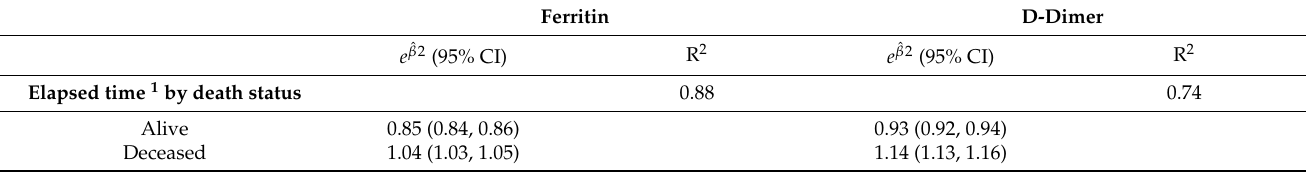
Table 5. Both ferritin and D-dimer levels consistently decreased over time for patients who remained alive, while increasing over time for patients who eventually died. Table 5. Associations of elapsed time and death status with ferritin and D-dimer levels.